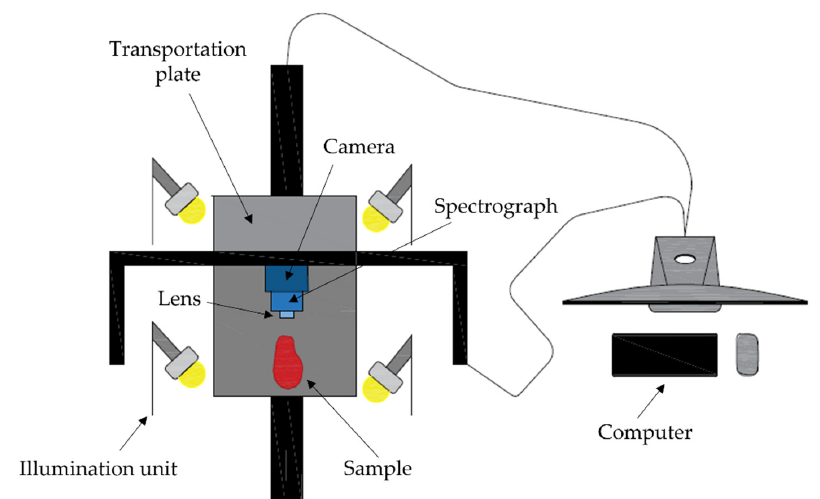
Figure 2. Schematic representation of the components that constitute the hyperspectral imaging sys-